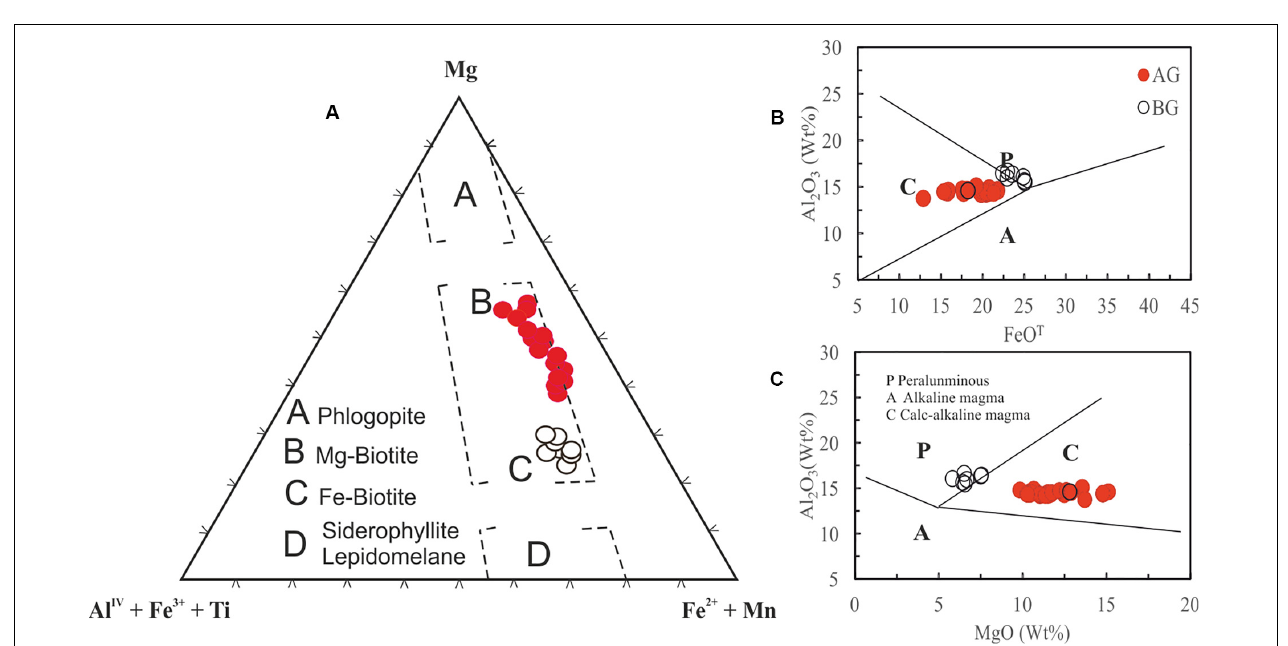
FIGURE 7 | Compositions of biotites from Batié granites in (A) triangular diagram after Foster (1960) and (B,C) after Abdel-Rahman (1994).